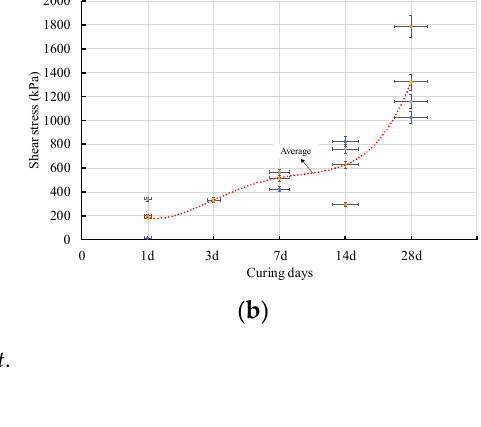
Figure 14. Average peak shear stress at different curing ages. ( a ) Shear angle of 40° . ( b ) Shear angle of 50°. ( c ) Shear angle of 60°.